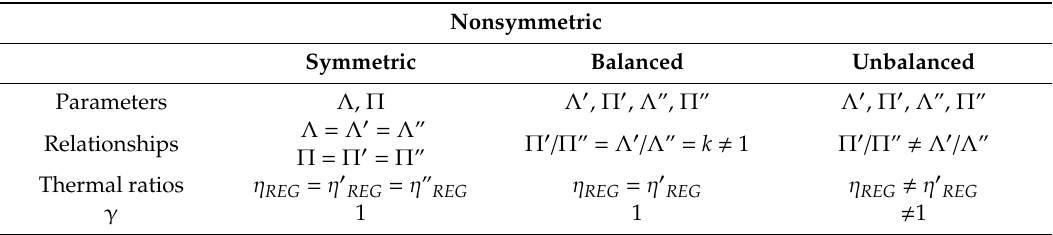
Table 1. Possible types of